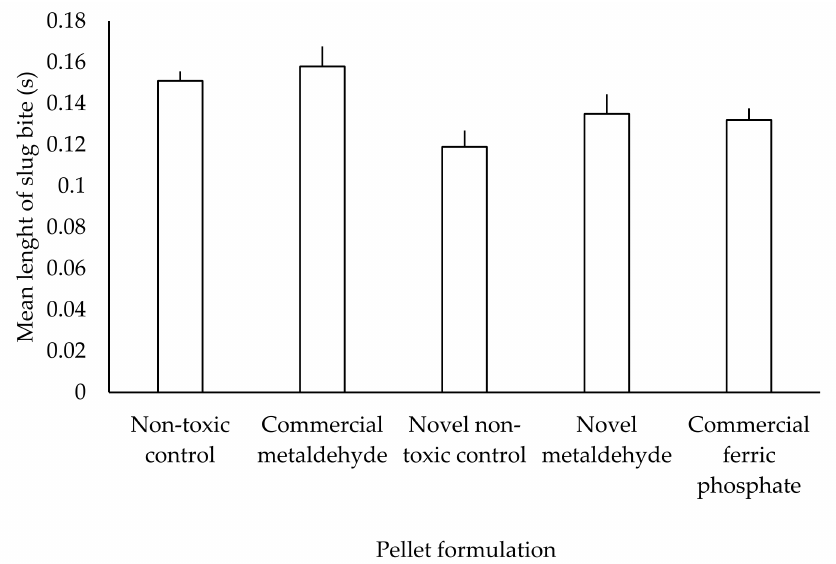
Figure 3. Mean lengths (+SD) of slug bites on different pellet formulations in laboratory trials. Non-toxic control (n = 24), commercial metaldehyde (n = 11), novel non-toxic control (n = 7), novel metaldehyde (n = 9) and commercial ferric phosphate (n =